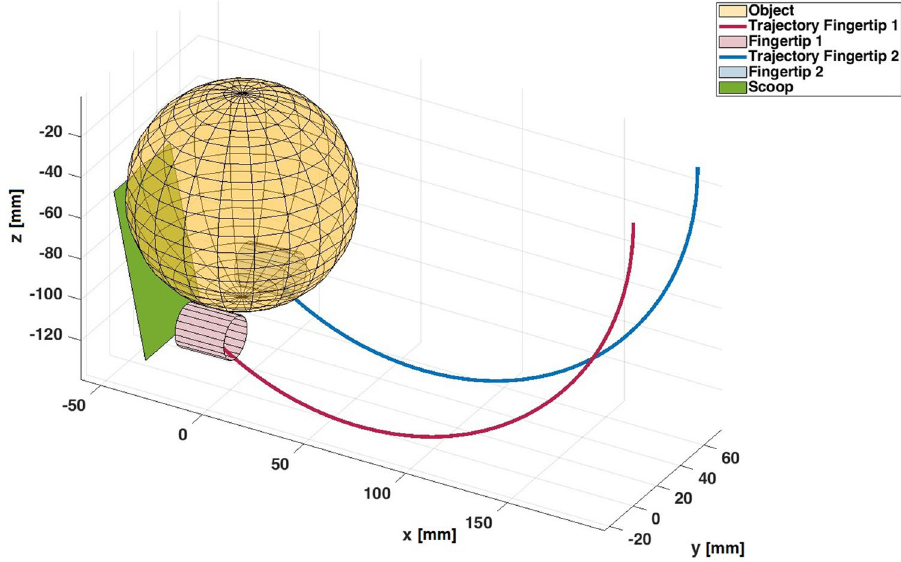
Fig. 6 Position analysis during grasping of a spherical